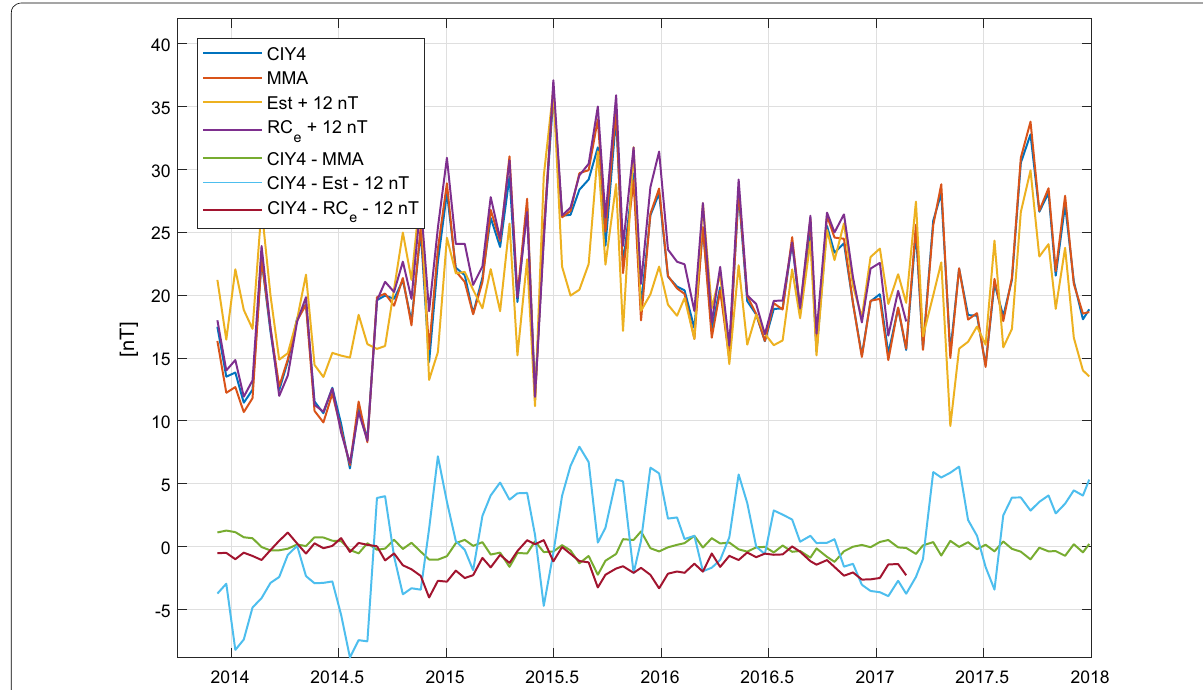
Fig. 14 The top set of curves shows the 15‑day averages of q 0 1 as estimated in CIY4 (blue curve), in comparison with the corresponding coefficient from the Swarm MMA data product (red), − Est (yellow), and − RC e (purple). The bottom set of curves shows the differences of the various estimates. See text for